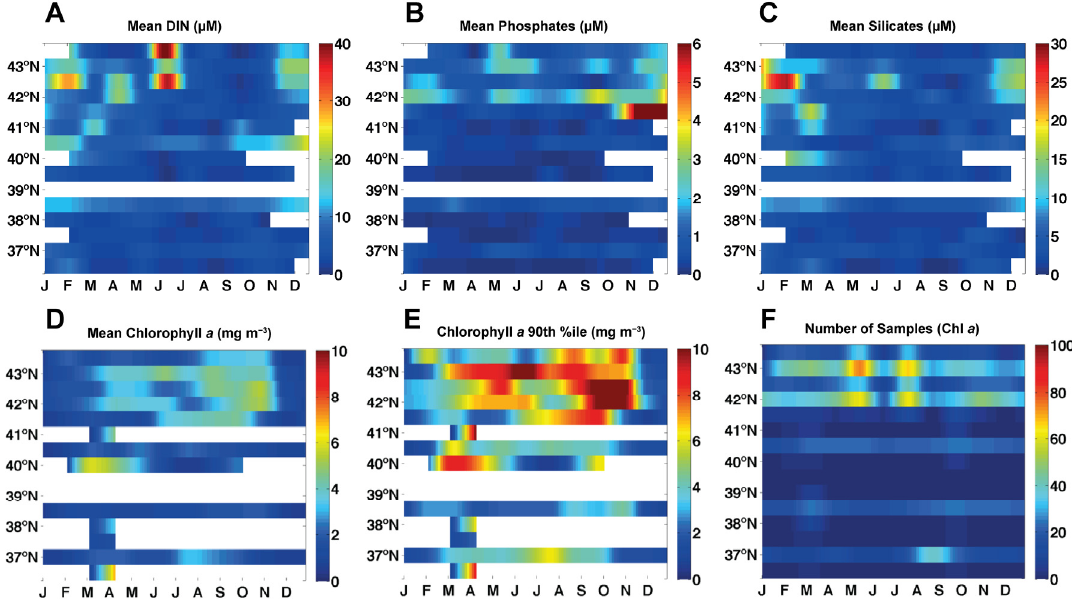
Figure 3. Temporal and spatial (north–south) coverage of in situ data: nutrients ( A ) Dissolved inorganic nitrogen; ( B ) Phosphates; ( C ) Silicates and Chl a concentrations ( D ) Mean Chl a concentrations; ( E ) Chl a 90th percentile (P90). The number of Chl a samples available is also presented ( F ). Table 1. Main statistical parameters for following variables: salinity, Chl a (mg m − 3 ), dissolved 2